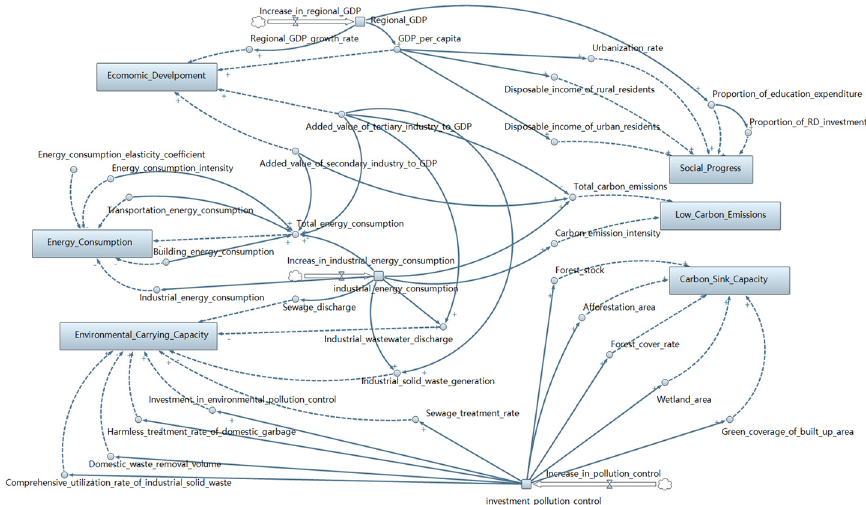
Figure 3. System dynamic